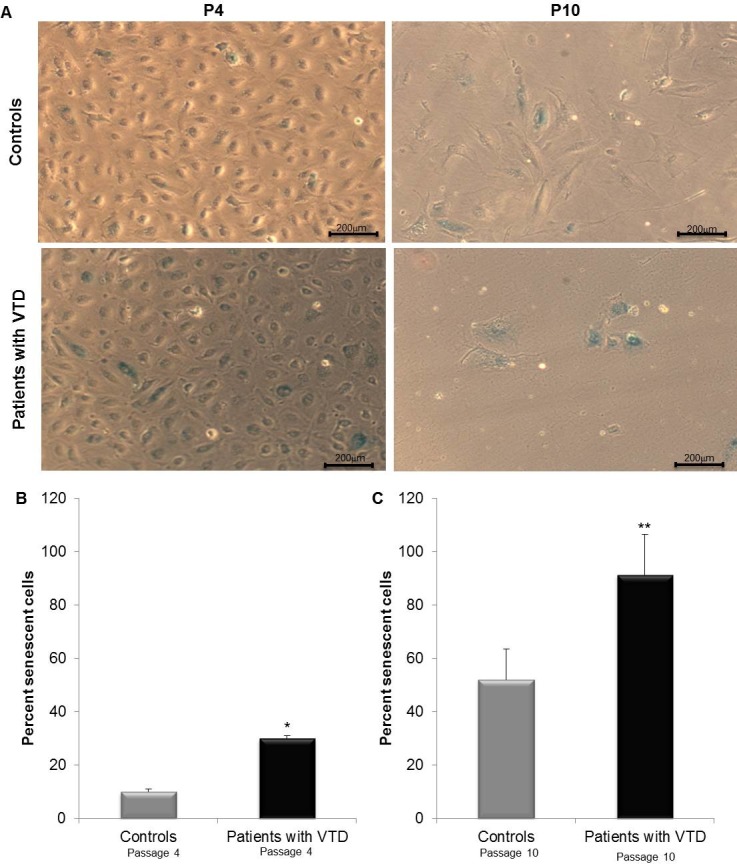
Senescence in ECFC-ECs obtained from peripheral blood of controls and patients with VTD.SA-β-gal activity analysis was used as a marker of cell senescence. (A) Representative images from controls and patients with VTD-ECFCs at passage 4 (P4) and 10 (P10) (upper panel, magnification X100; scale bar, 200 μm). (B) Percentage of senescent cells in patients with VTD-ECFCs was determined with the number of cells expressing SA-β-gal (blue cells) related to the total number of cells/field from patients with VTD (n = 3) or controls (n = 3). Graph (lower panel) represents mean ± SEM of five independent samples. Experiments were done in triplicate. *P = 0.001 (patients with VTD vs. controls at passage 4); **P = 0.023 (patients with VTD vs. controls at passage 10).